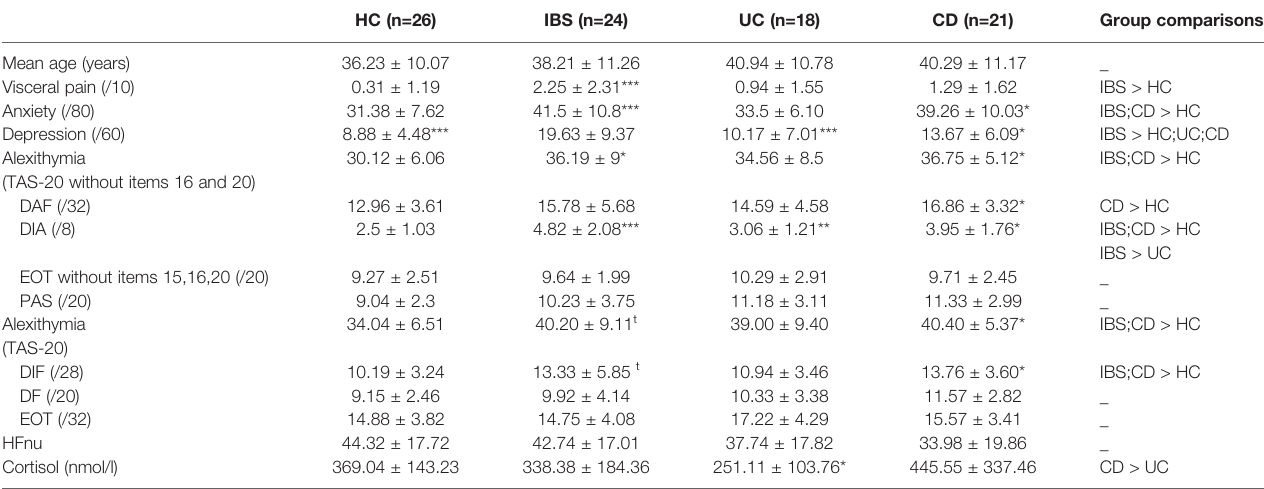
TABLE 1 | Socio-demographic, medical, and psychological